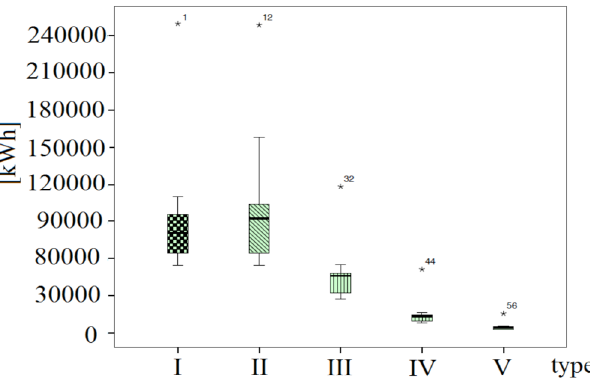
Fig. 5. Energy consumption by type of household.